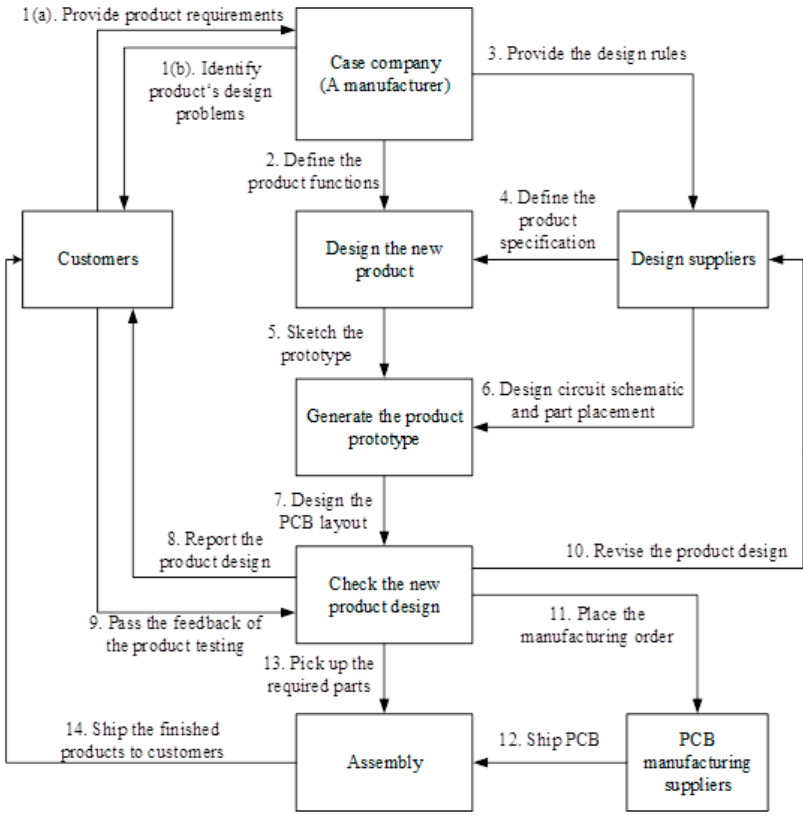
Figure 5. New PCB R&D process.